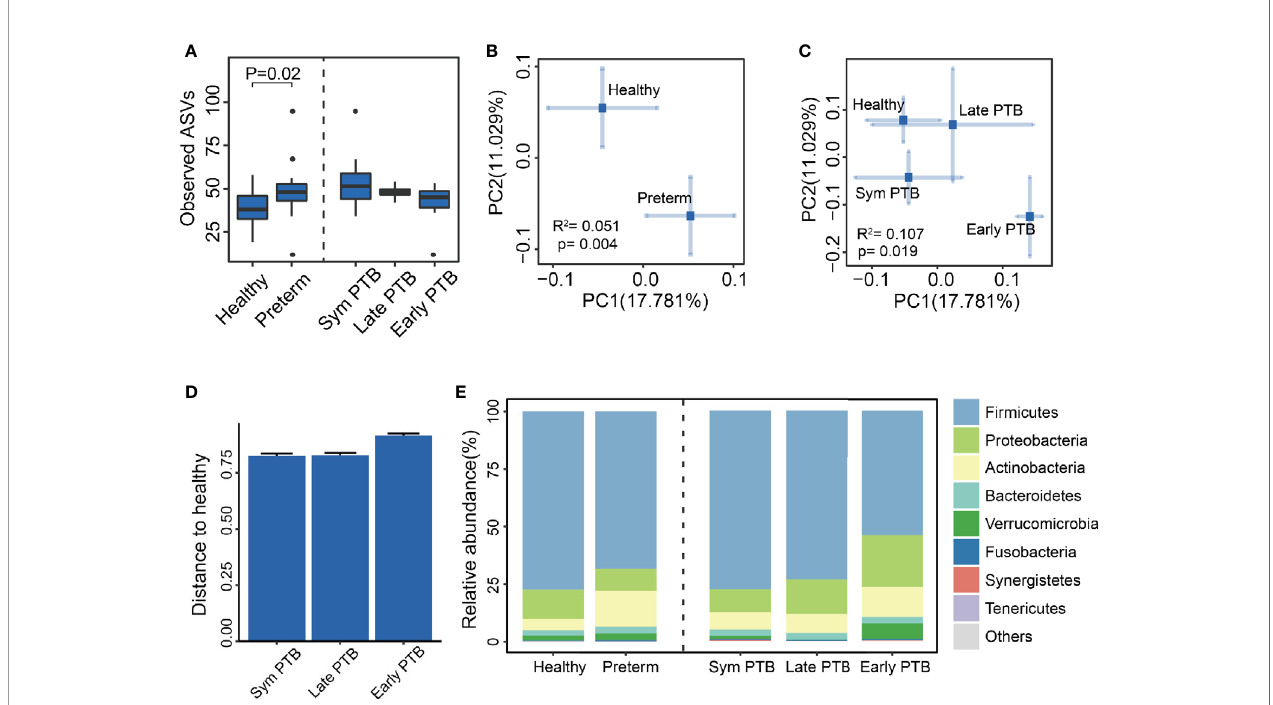
FIGURE 1 | The diversity and composition of the gut microbiome. (A) Observed ASVs of all groups. Observed ASVs between the healthy group and the preterm group (Wilcoxon rank-sum test), along with the preterm symptoms delivered group (Sym PTB), late-week preterm group (Late PTB) and early week preterm group (Early PTB). (Subgroups are compared with healthy group using Wilcoxon rank-sum test and adjusted by the Benjamini and Hochberg method). (B, C) Bray – Curtis distances PCoA of all groups. PCoA of Bray – Curtis distances for the bacterial community structure of the gut microbiome between the healthy group and the preterm group (B) , the healthy group and the Sym PTB group and the late PTB group and the early PTB group. (C) The eigenvalues of axe PC1 and PC2 were 0.29 (17.781%) and 0.46 (11.029%), respectively. The eigenvalues of axe PC1 and PC2 were 0.60 (17.781%) and 0.97 (11.029%), respectively. PERMANOVA was employed. (D) Preterm subgroup distances to healthy group. The distance of the preterm birth subgroups to the healthy group, based on Bray – Curtis distances. (E) Relative abundance of all groups. Comparison of the relative abundance of the dominant phylum in the healthy group, the preterm group, and the preterm birth